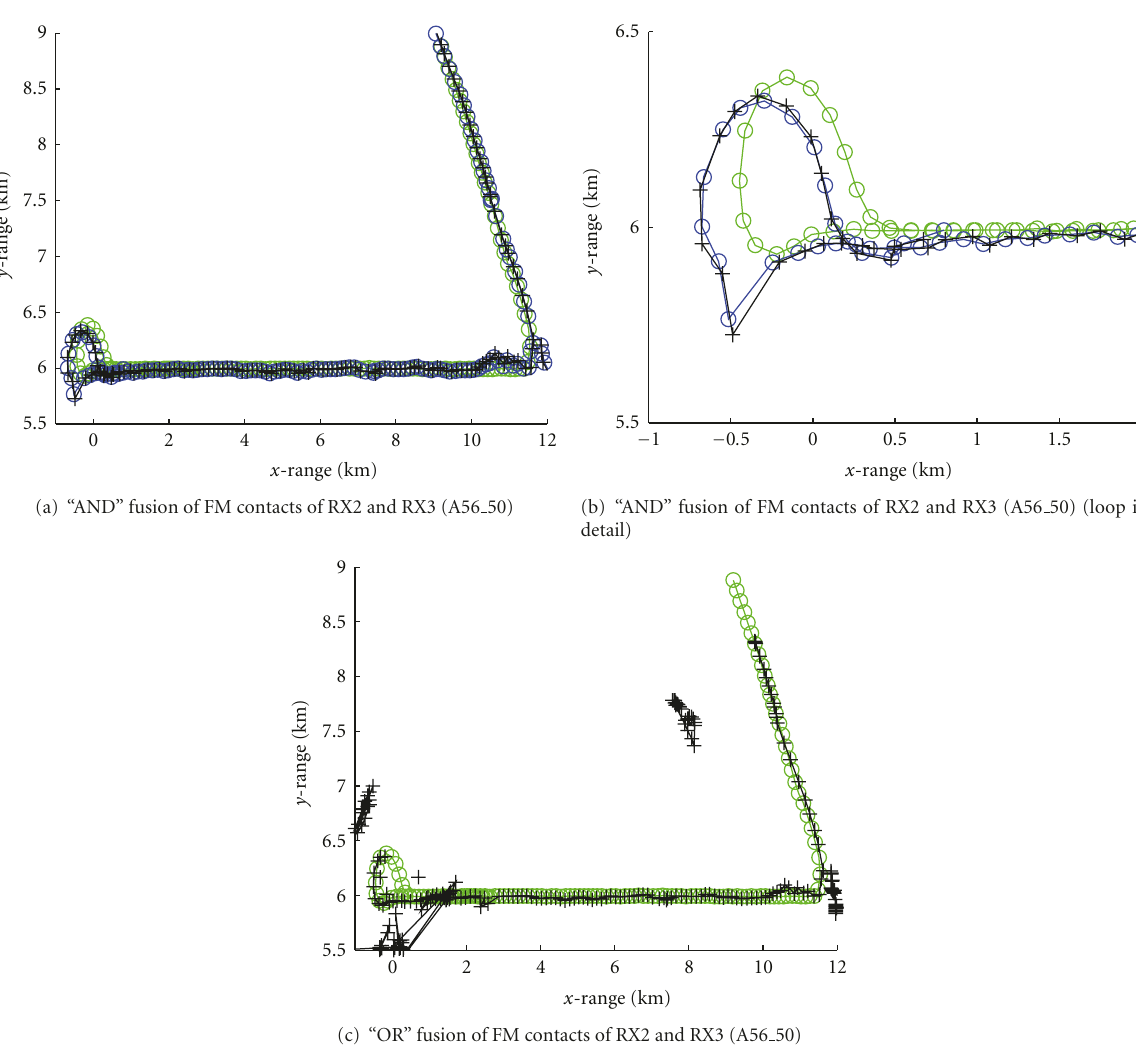
Figure 16: Tracking results for “AND” (a), (b) and “OR” fusion of FM contacts of RX2 and RX3 (c). In (a,b) the approaches NoCor (black plus sign) and DoTiCor (blue circle) are compared. For better visualization false tracks are not displayed: track estimates of the NoCor and DoTiCor approach are shifted. Both approaches show up to be slightly inflexible to derivations from the movement